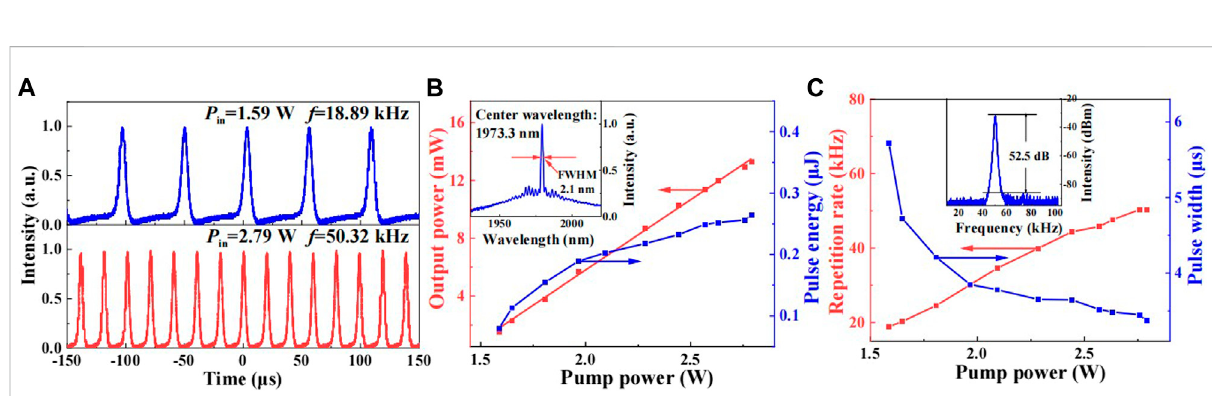
FIGURE 7 (A) Q-switched pulse trains at the launched pump power of 1.59 W and 2.79 W; (B) Output power and single-pulse energy as functions of the pumppower, inset:opticalspectraoftheQ-switchedpulses; (C) repetitionrateandpulsewidthasfunctions ofthepumppower,inset: RFspectraof the Q-switched